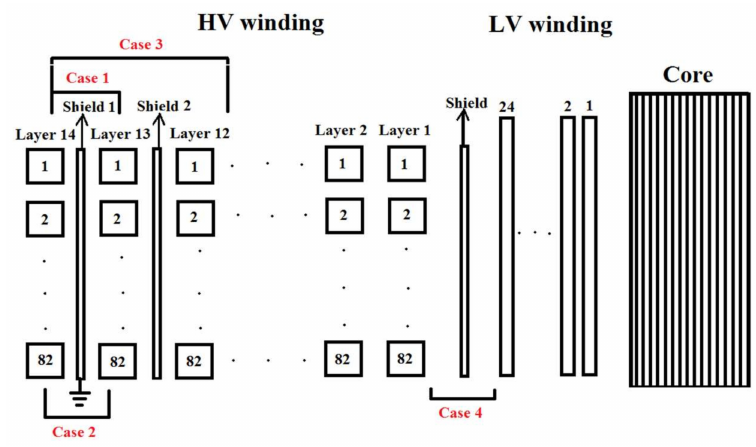
Figure 14. Transformer winding model with di ff erent cases of shield placement. Table 7. Modified RLC parameters of HV winding with shield placement between layer 14 and layer 13.